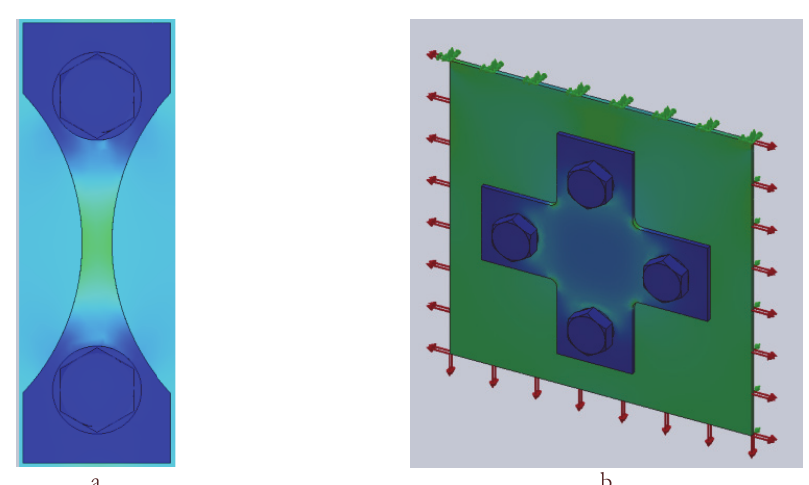
Figure 6: Sensors for fatigue monitoring: a) uniaxial fatigue; b) biaxial